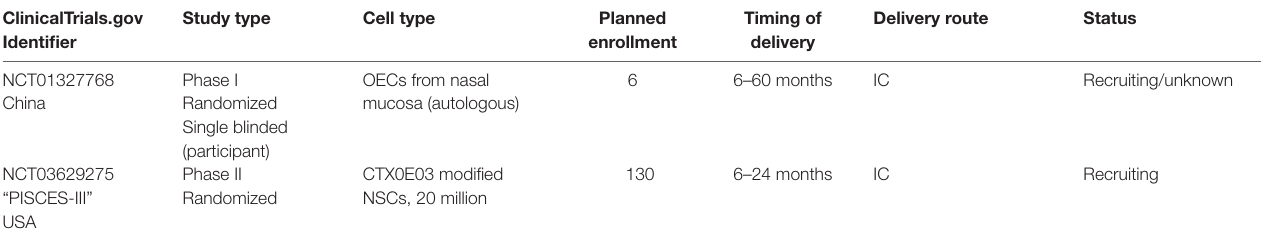
TABLE 5 | Ongoing and pending unpublished neural lineage